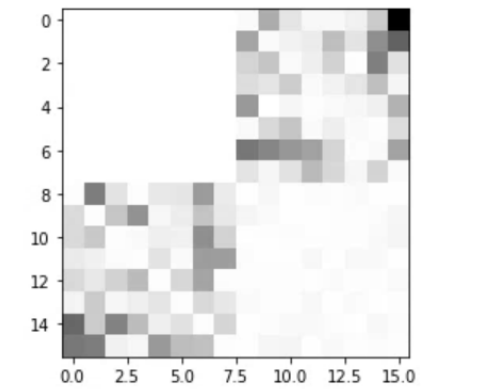
Figure 15. Error distribution between ground truth data and output data (the darker the color, the greater the